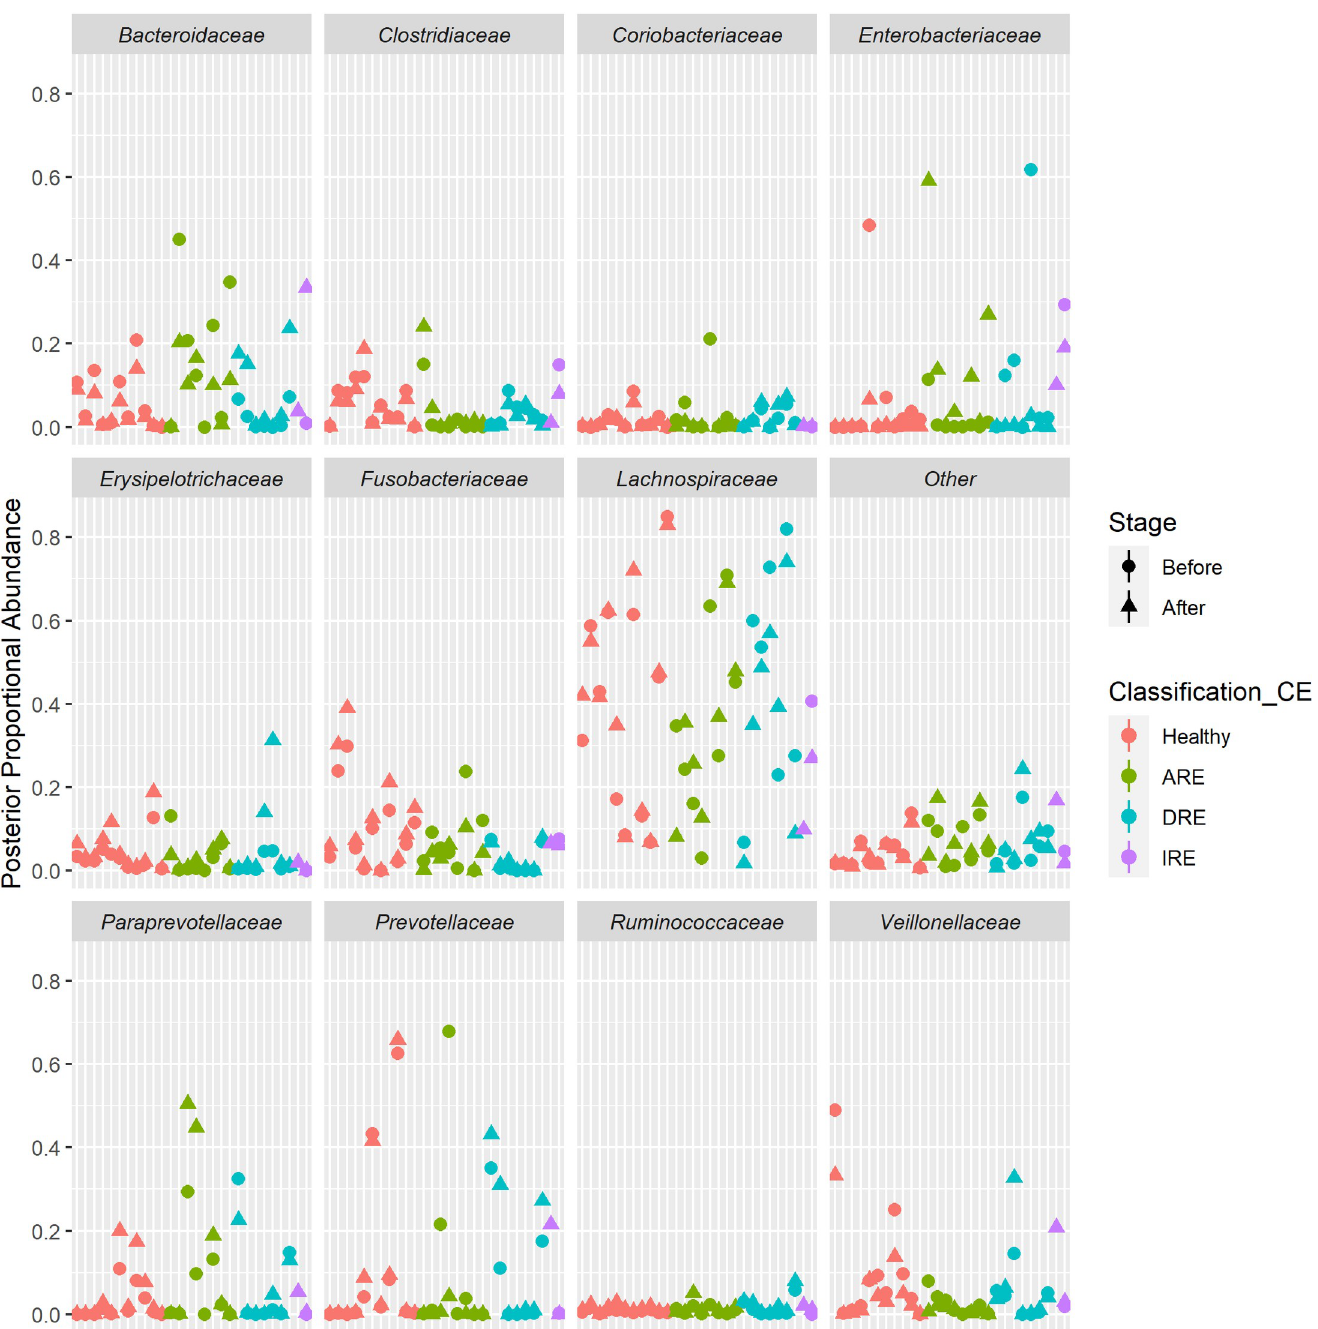
Fig 5. The subject estimate of the proportional abundance of the different families in the input (pre-sort) population. DRE: Diet-responsive enteropathy. ARE: Antibiotic-responsive enteropathy. IRE: Immunosuppressant-responsive enteropathy. ‘Before’ corresponds to V1 in healthy dogs and Active disease in CE dogs. ‘After’ corresponds to V2 in healthy dogs and remission in CE dogs. Top eleven of the most represented families. Other includes the remaining families.